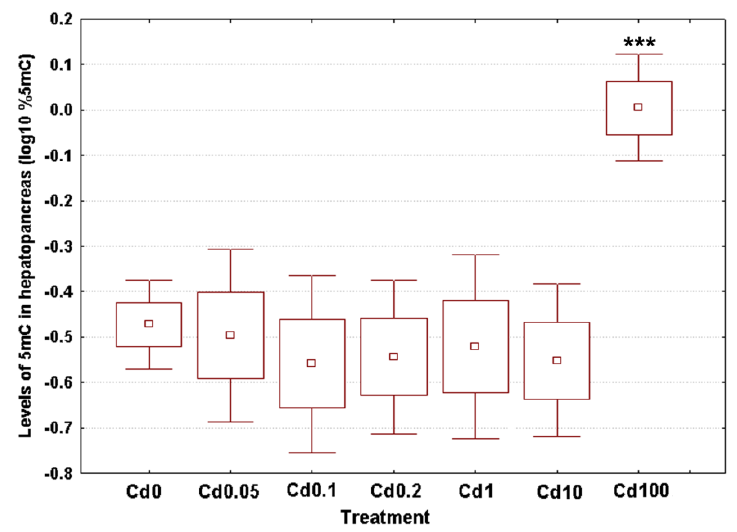
Figure 3. Effect of dietary cadmium on genome-wide 5mC levels in DNA of the hepatopancreas of C . aspersum adults ( n = 4). Data are shown on a log 10 scale as mean (point) with one standard error (box) and one standard deviation (error bar) (Dunnet’s tests, ***— p < 0.001, **— p < 0.01, *— p < 0.05).